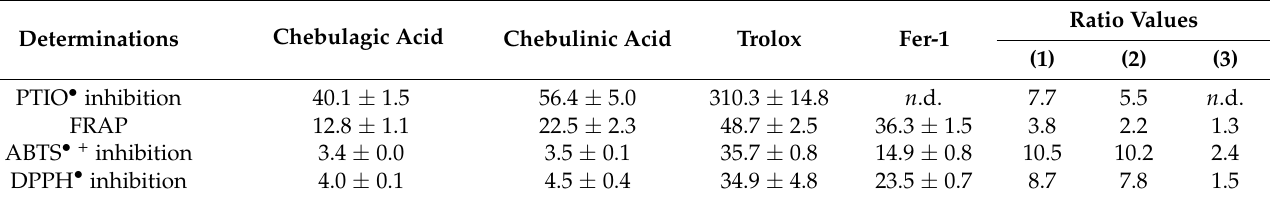
Table 1. IC 50 values ( µ M) of chebulagic acid, chebulinic acid, Trolox, and Fer-1 in antioxidant determinations.